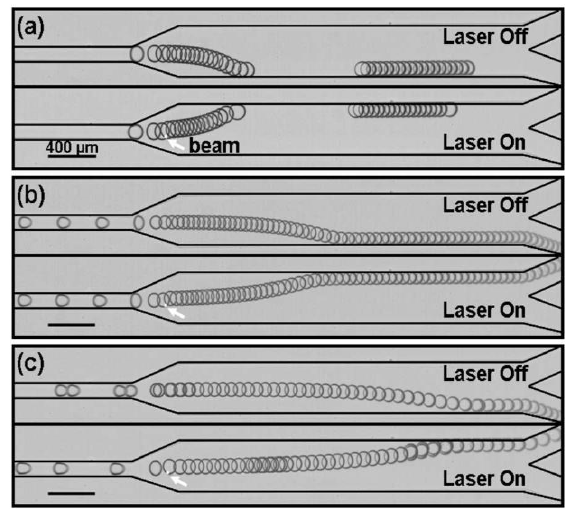
Figure 30. Superposition of successive frames illustrating drop switching by local thermocapillary actuation. The arrow indicates the laser location observed by the fluorescence of the water-dye solution. ( a ) Qo/Qw = 5/0.05, U = 2.6 mm/s, R = 60 µm, P = 58 mW, frame rate 50 frames/s. ( b ) Qo/Qw = 10/0.1, U = 6.1 mm/s, R = 54 µm. P = 111 mW, frame rate 100 frames/s. ( c ) Qo/Qw = 15/0.2,U = 13.0mm/s, R = 55 µm. P = 159 mW, frame rate 100 frames/s. Flow rates are expressed in µl/min. Reprinted with permission from [68]. Copyright 2008, American Institute of